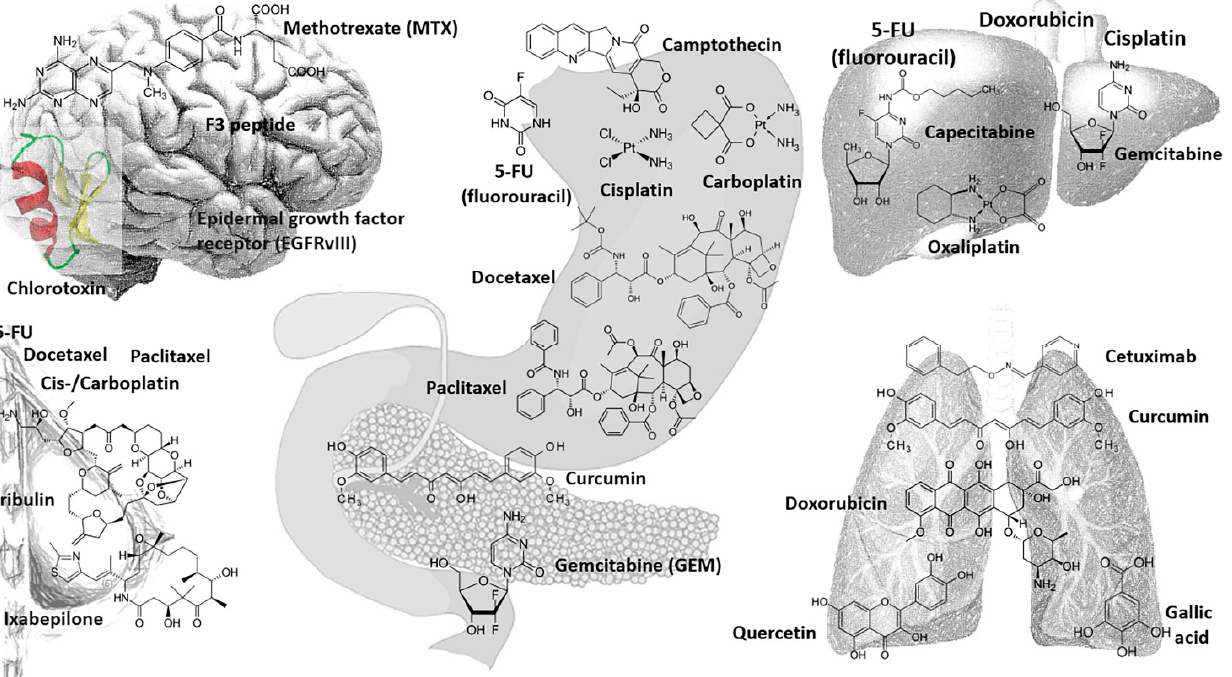
Figure 4. Magnetic NPs with anchored anticancer drugs and chemical formula attached. The drugs have been grouped by target organ, depicted as transparent background (brain, stomach–pancreas, liver, breast, lung).